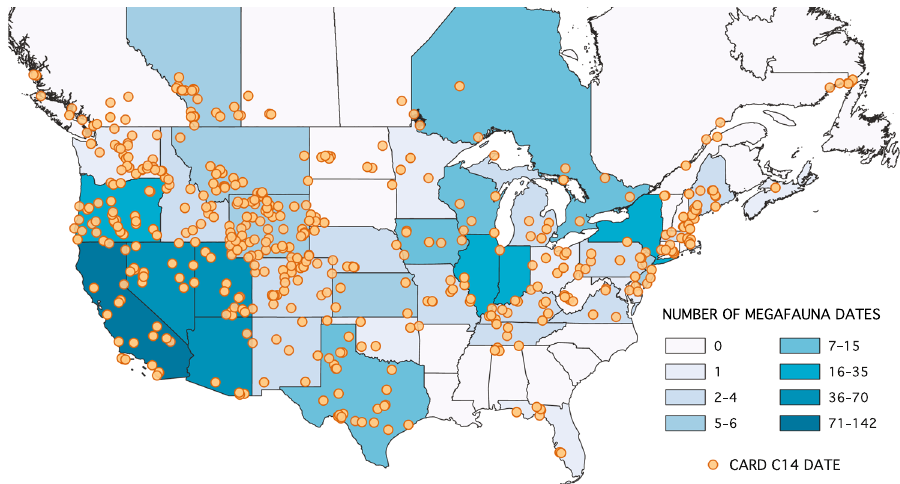
Fig. 1 Map of the study area. Contiguous United States and southern Canada with archaeological site locations (orange circles) and frequency of dated megafauna remains by state. Map recreated using data from Broughton and Weitzel 24 under the CC BY license